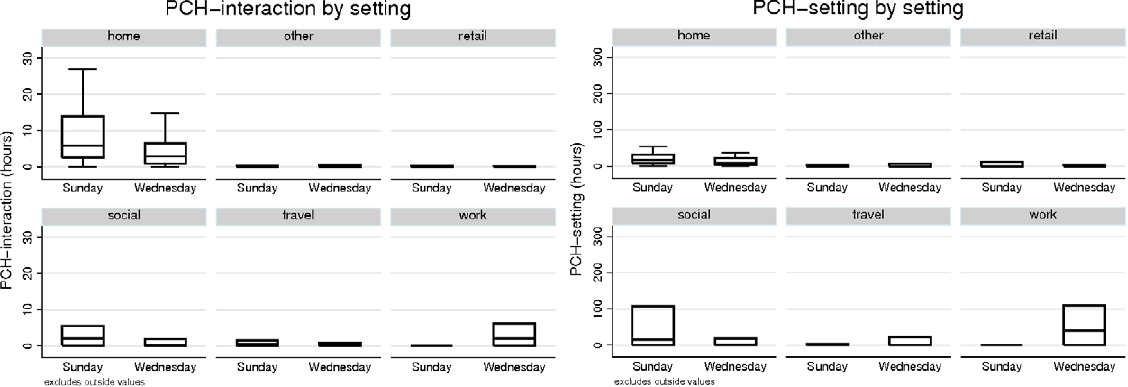
Figure 2. PCH measures for each setting category. PCH-interaction (left) and PCH-setting (right) measures by day and location, in units of hours. Note that PCH-reach distributions are statistically similar to PCH-interaction distributions and omitted here. Also note that outside values are not shown.